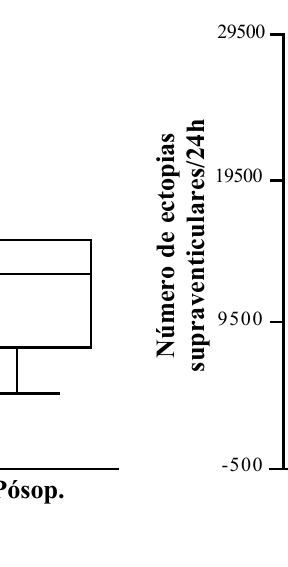
Figura 2 - Número de extrasístoles supraventriculares pelo Holter de 24 horas no pré e